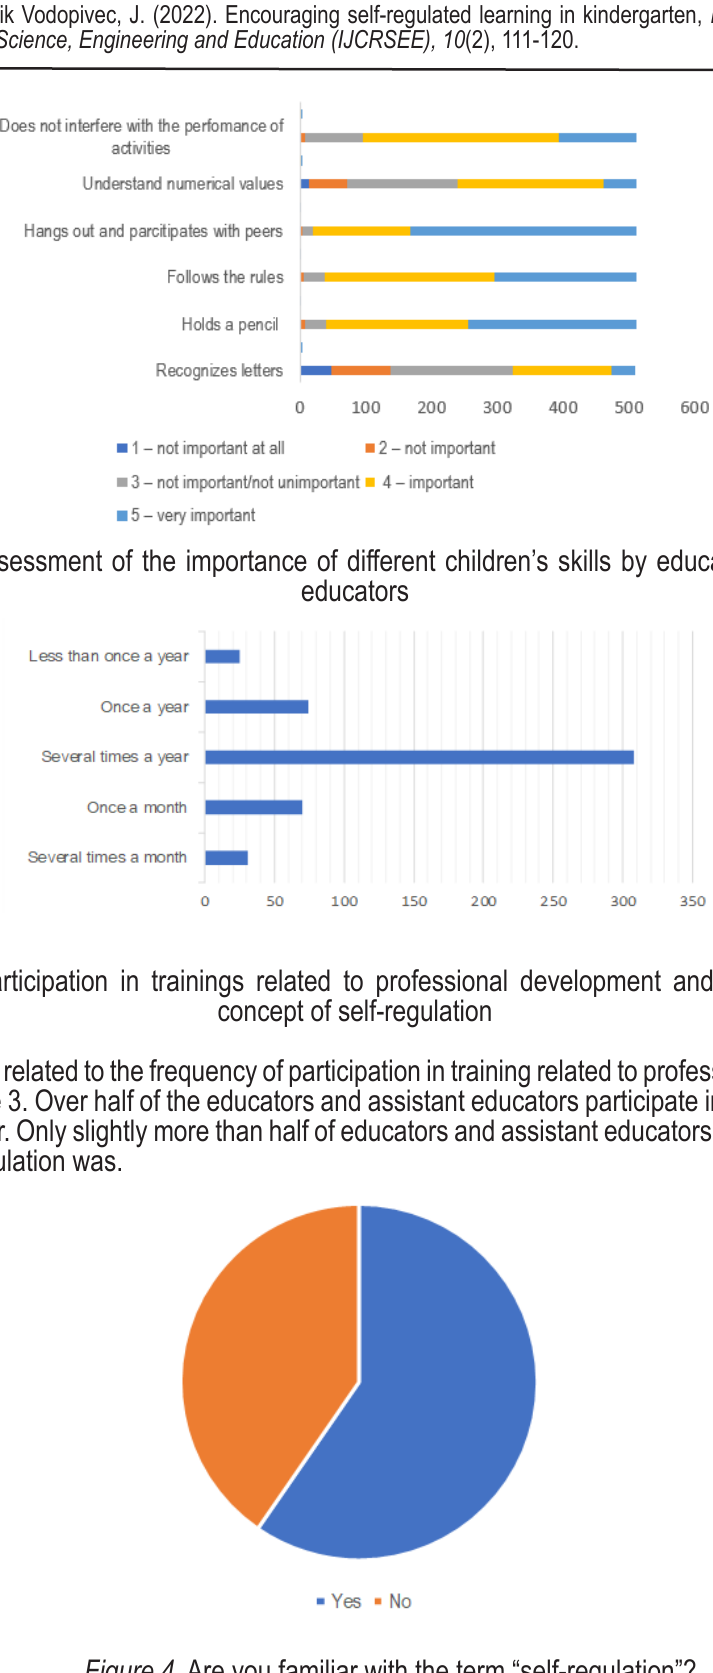
Figure 4. Are you familiar with the term